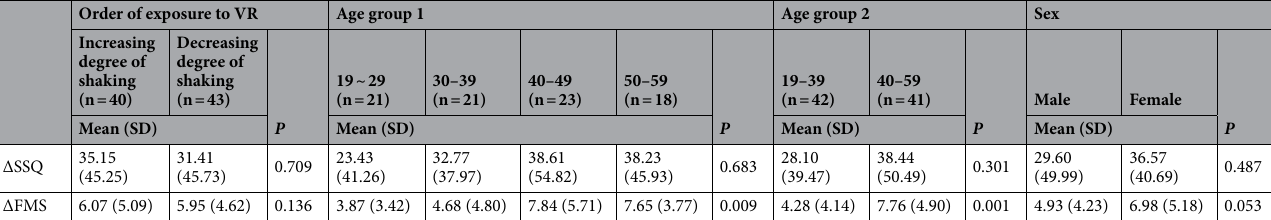
Table 2. Change in SSQ and FMS after application of VR according to shaking of VR, age group, and sex. SSQ Simulator Sickness Questionnaire, FMS Fast Motion sickness Scale, VR virtual reality, SD standard